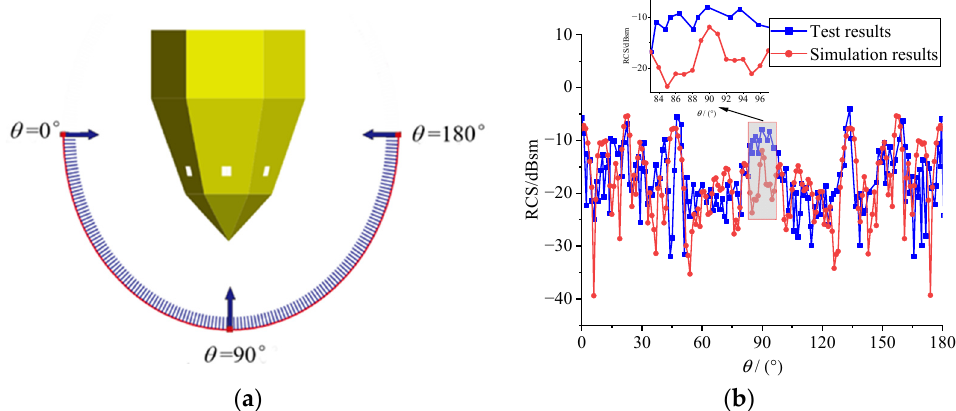
Figure 1. Anechoic chamber test verification. ( a ) Schematic diagram of incident wave. ( b ) Comparison of test and simulation results. Table 1. In-orbit parameters of TX-1 stealth microsatellite.